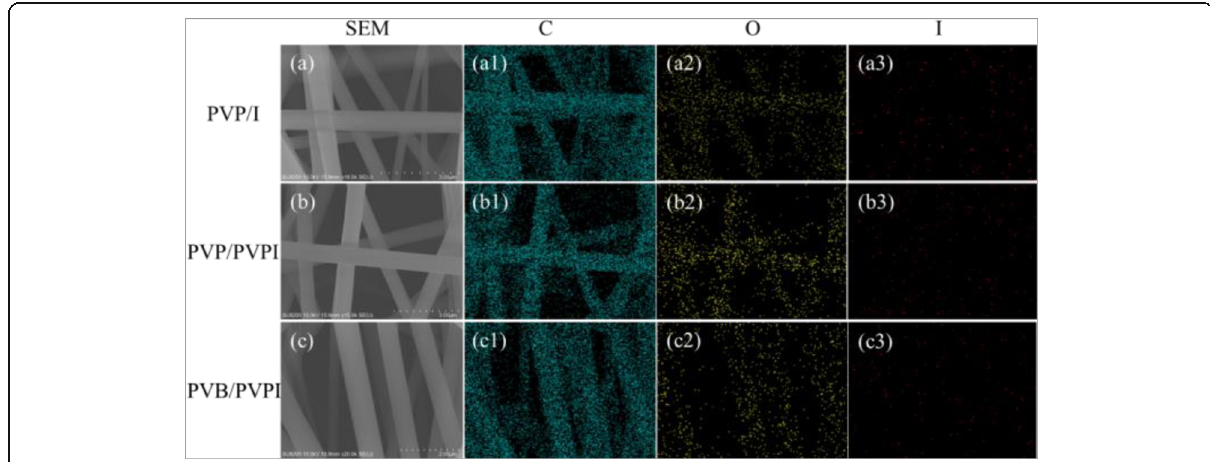
Fig. 3 Different elements of EDS images of the as-spun PVP/I (a – a3), PVP/PVPI (b – b3), PVB/PVPI (c – c3) fibers with 5% I/PVPI